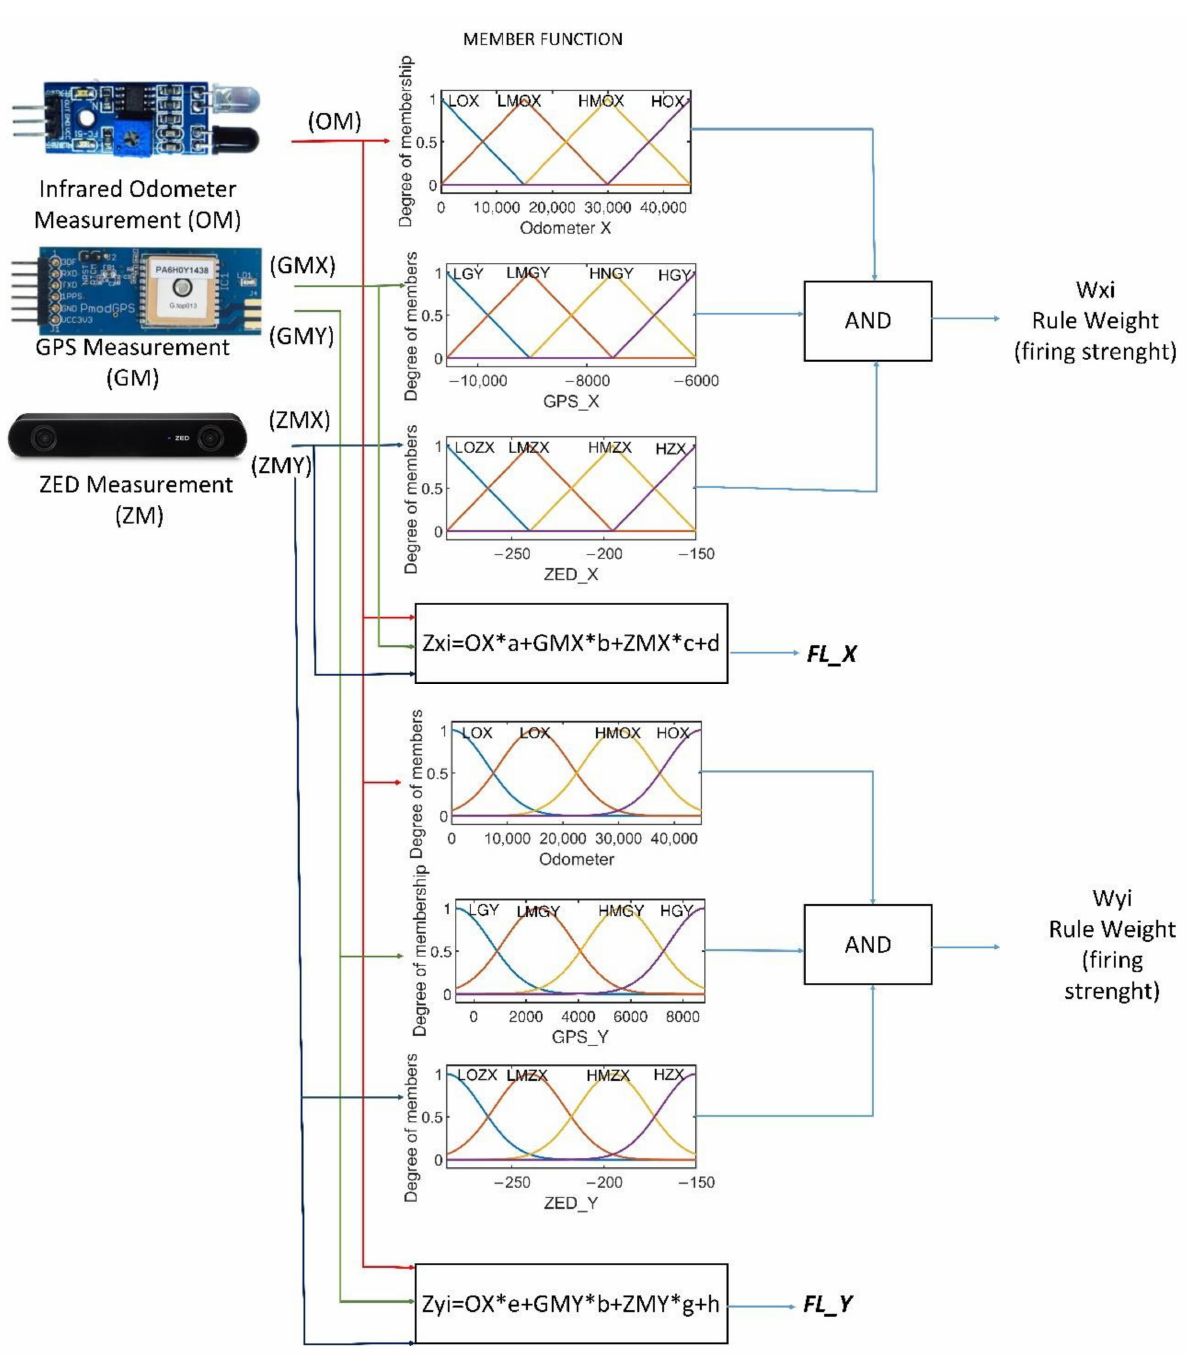
Figure 7. Takagi-Sugeno